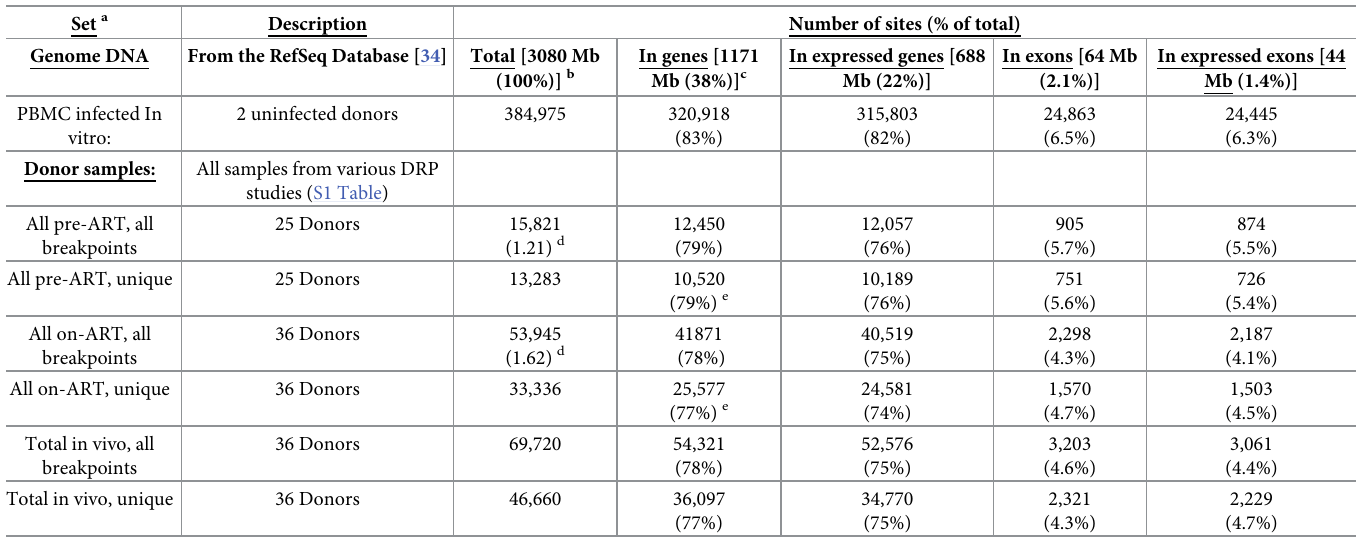
Table 1. Integration datasets used in this